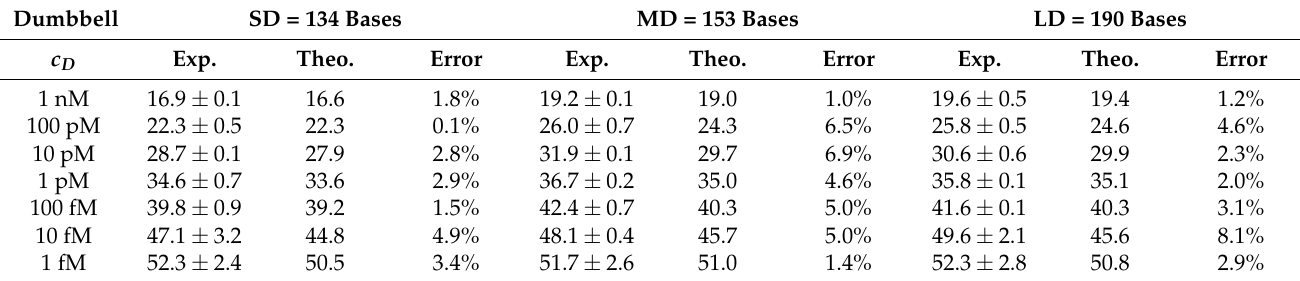
Table 2. Experimental ( n = 2) versus theoretical predictions for the time at half saturation t 50 in minutes as function of the dumbbell lengths and concentrations. The experimental error is set as the standard deviation values calculated from the replicates. The fit at the reference concentration (1 nM) was used to determine t 5 0[Ref] and k . The theoretical values were then determined from Equation (17). The column named Error reflects the variation between the experimental results (values at half saturation) and the theoretical